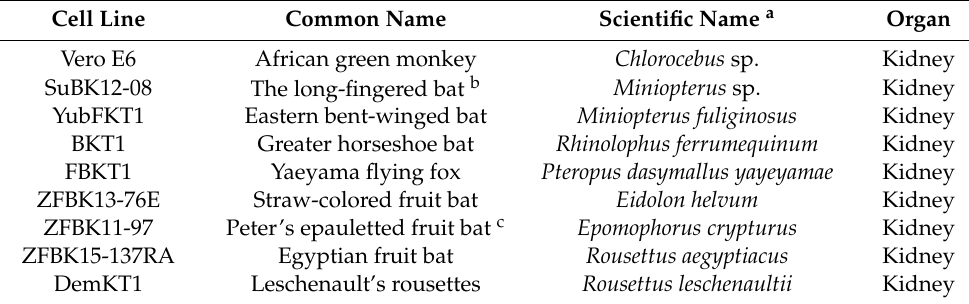
Table 1. Origins of cell lines used in this